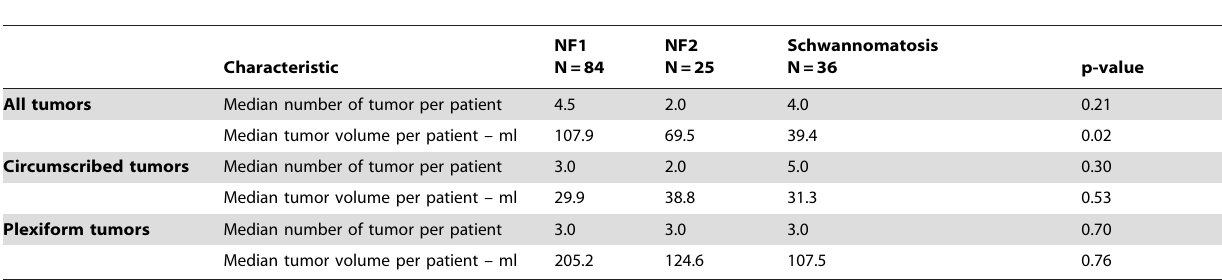
Table 3 . Whole-body tumor number and volume in patients with at least 1 internal tumor.